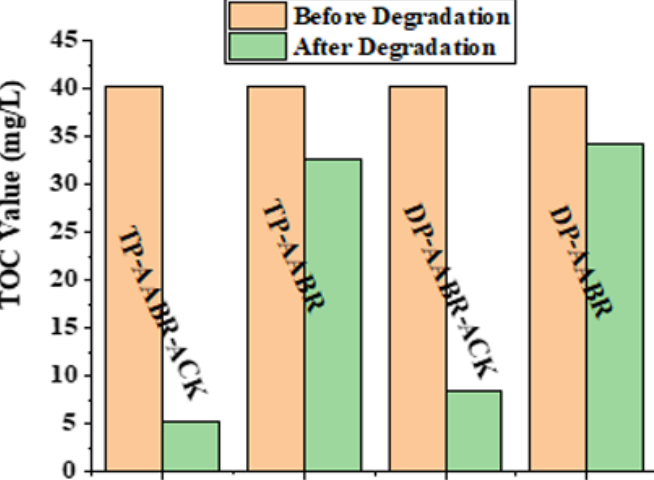
Figure 9. TOC changes of TC before and after photocatalytic reaction using as-prepared samples.